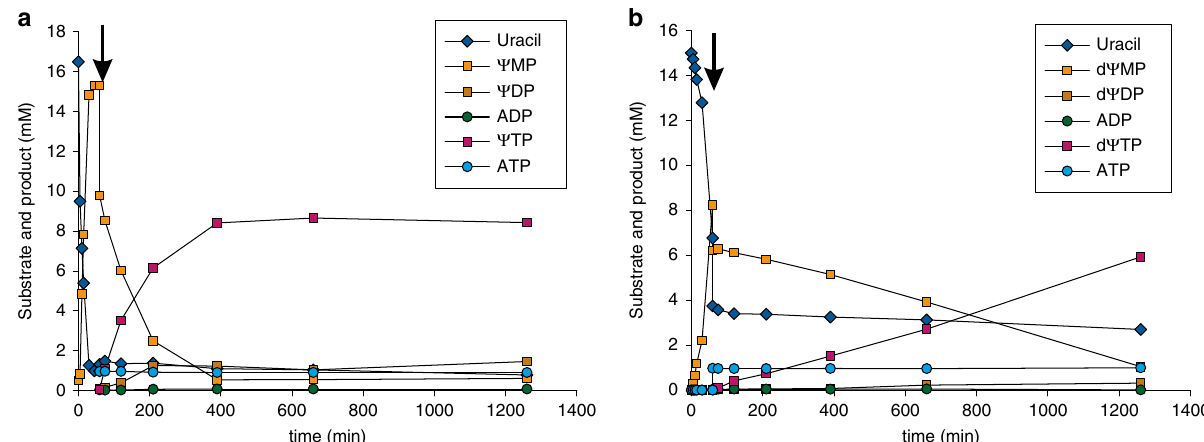
Fig. 5 Enzymatic cascade synthesis of Ψ TP and d Ψ TP. Panels a and b show Ψ TP and d Ψ TP, respectively. Pentoses (100 mM) were phosphorylated applying RbsK (15 µ M for D -Rib; 30 µ M for D -dRib) and pyruvate kinase (4 µ M) using 100 mM PEP and 2 mM ATP as phosphate donors (see